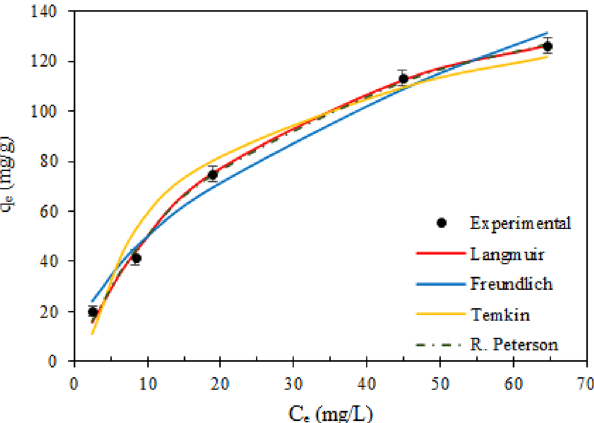
Figure 11. Isotherm models used to fit experimental data for the PNP adsorption on TMA-(PA6- g -GMA) fibrous via Langmuir, Freundlich, Temkin, and Redlich Peterson at 298 K, pH 5, adsorbent dose = 0.1 g, volume of solution = 100 mL and agitation speed = 150 rpm.